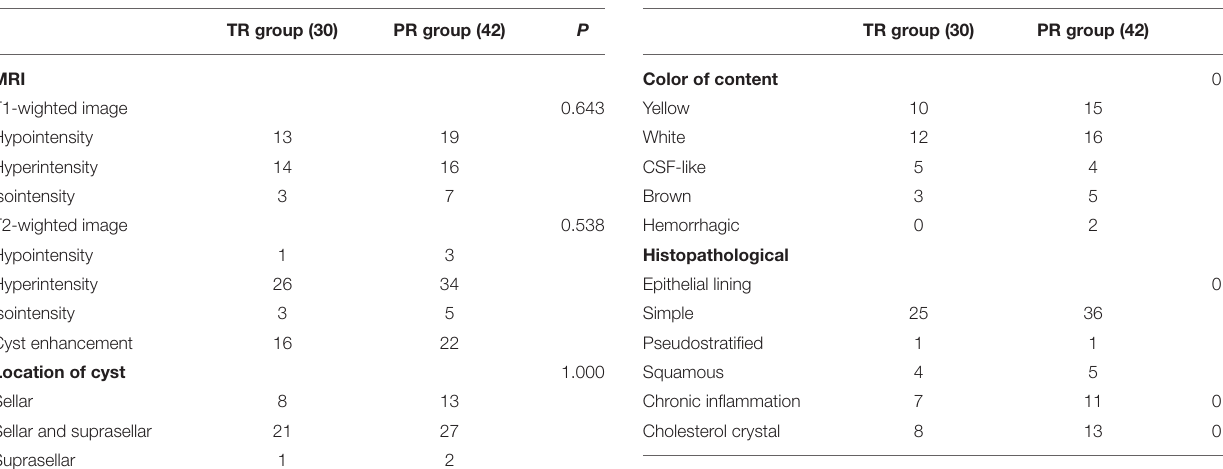
TABLE 2 | MRI features of 72 Patients with RCC.